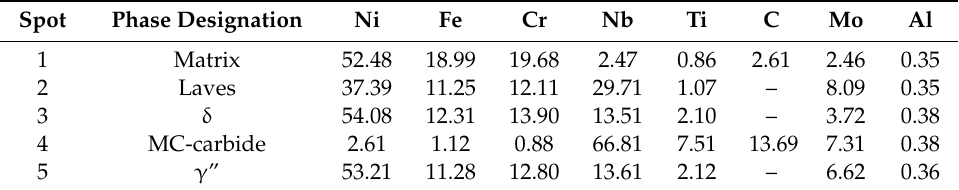
Figure 3. SEM images of the Inconel 718 superalloy after different heat treatments: ( a , b ) SHT; ( c , d ) HIP + STA; ( e , f ) HIP + DA. Table 1. The results of the EDX analysis of the Inconel 718 superalloy after different heat treatments from Figure 3 (wt.%).